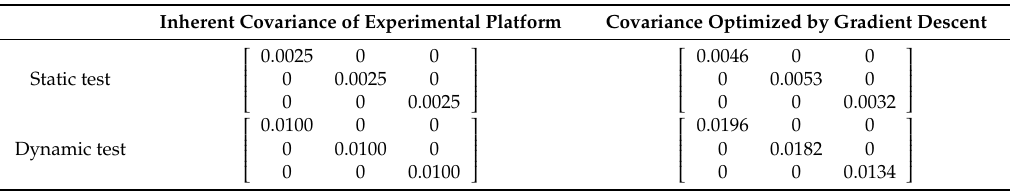
Figure 7. Roll angle test of support attitude sensing system: ( a ) roll angle estimation based on three methods; ( b ) roll error of three methods. Table 1. Process noise